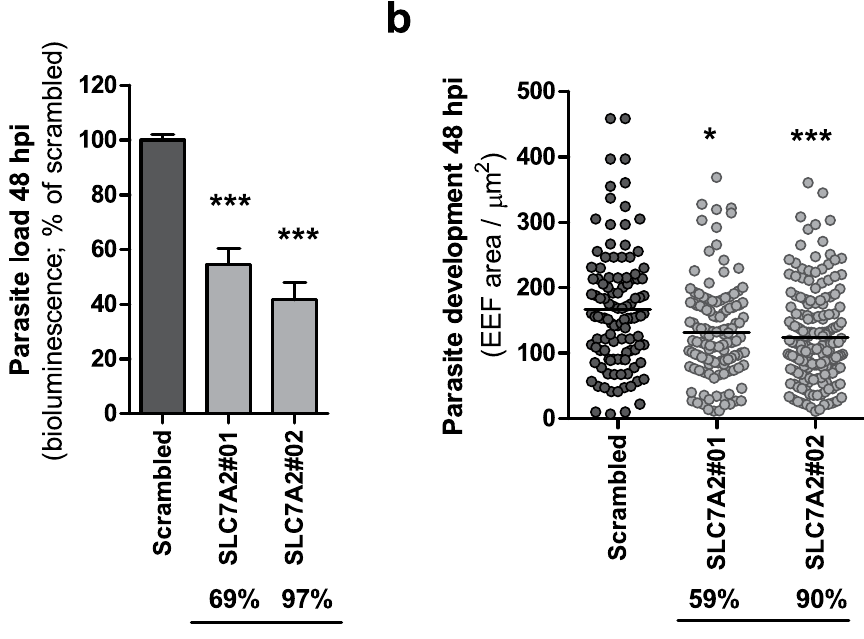
Figure 1. SLC7A2 knockdown significantly impairs P . berghei intra-hepatic development. ( a ) Two different lines of Huh7 cells with stable knockdown of SLC7A2 were infected with luciferase-expressing P . berghei sporozoites and parasite load (luminescence) was assessed 48 h later. A scrambled shRNA sequence was used as a negative control. Error bars represent SEM. Pool of 4 independent experiments. ( b ) Quantification of the area of the EEFs in the 2 cell lines with SLC7A2 knockdown at 48 hpi by immunofluorescence microscopy. The knockdown efficiency of each shRNA sequence is indicated below each graph. Representative experiment out of 3 independent experiments. Both panels: Kruskal-Wallis with post-test Dunn’s. * p < 0.05 and *** p <